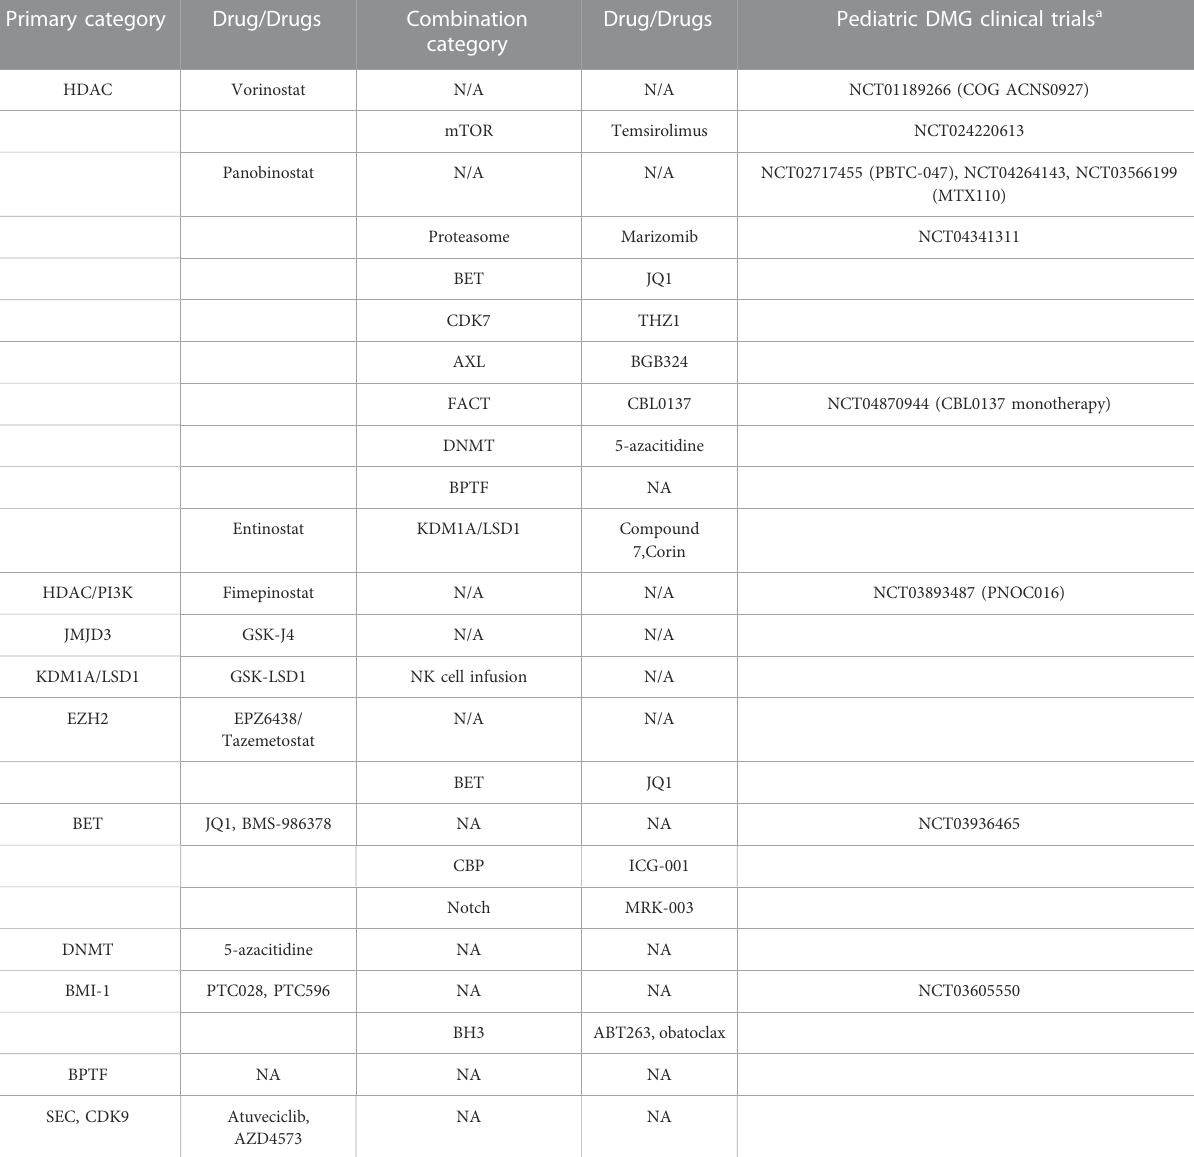
TABLE 1 Pre-clinical epigenetic targeting strategies and stage of clinical development. Primary